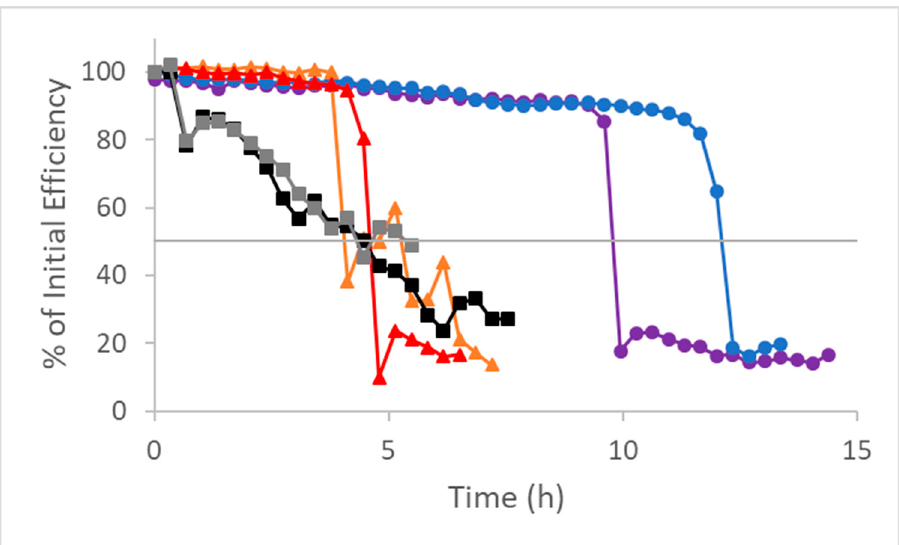
Figure 2. Effect of the pH of the challenge solution on the stability of 2.1 × 50 mm 1.6 µm CORTECS HILIC columns, shown as % of initial efficiency vs. time exposed to the basic solution. The columns were exposed at 70 °C to solutions containing acetonitrile and different aqueous buffers, with a 60/40 v / v ACN/buffer ratio (blue and purple circles, ammonium acetate, s w pH 6.99; orange and red triangles, ammonium bicarbonate, s w pH 8.96; black and gray squares, ammonium bicarbonate, s w pH